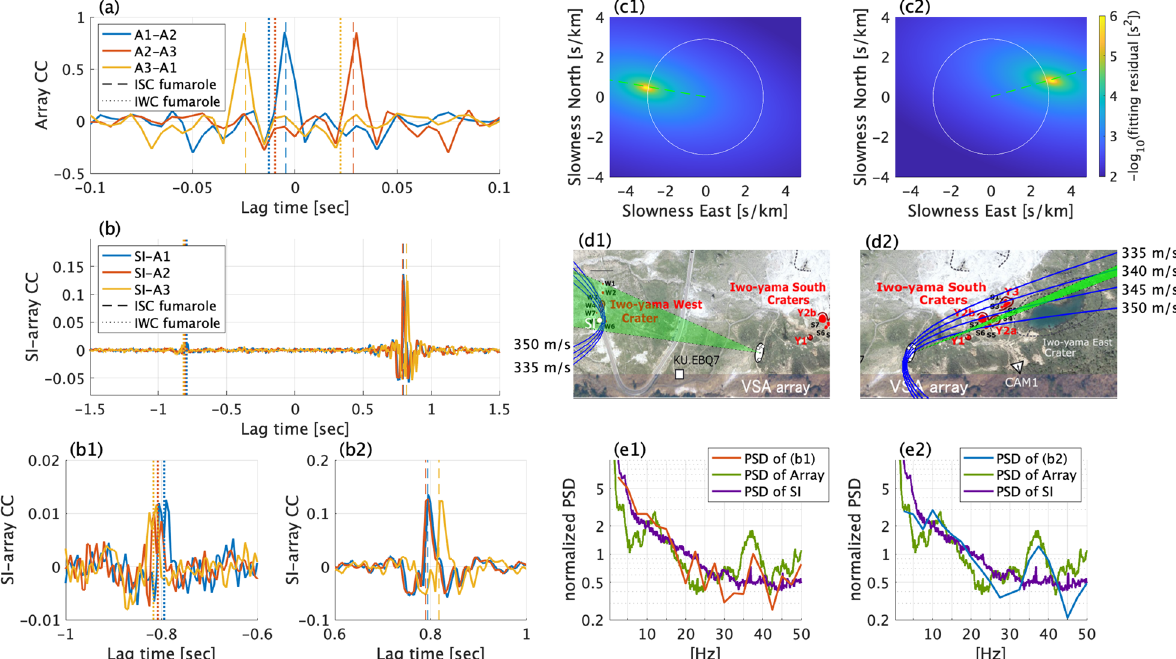
Fig. 3 Correlation coefficients (CCs) and the array analysis results. a The array CC and b SI-array CC at 5–80 Hz. Enlarged view of b around the minor peak ( b1 ) and the prominent peak ( b2 ). The vertical lines with the corresponding colors mark the calculated infrasound propagation time differences between the microphone pairs, assuming that the sources are located at the IWC fumarole (dotted lines) and the ISC fumarole (dashed lines). The lag time fitting results for the peaks in b1 and b2 are shown in c1 , d1 and c2 , d2 , respectively. c The fitting residual using all pairs of SI-array CC is shown as functions of horizontal components of the slowness. The white circles indicate acoustic slowness. d The blue curves indicate the source hyperbola obtained from the SI–A1 lag time fitting assuming the propagation velocities as 335, 340, 345, and 350 m/s. The green angle range from the VSA array shows the estimated back azimuth (2 STD) obtained from c . The white and red points mark the microphones’ and fumaroles’ locations, respectively. e The power spectra densities (PSDs) normalized by the power in the main bands ranging from 5 to 50 Hz, which were calculated using the three CCs in b1 and b2 are shown in e1 by the red line and in e2 by the blue line, respectively. They are compared with the PSD for the array microphones (green) and the PSD for the SI microphone (purple). For the former (the green line), the normalized PSDs for the individual array microphones are